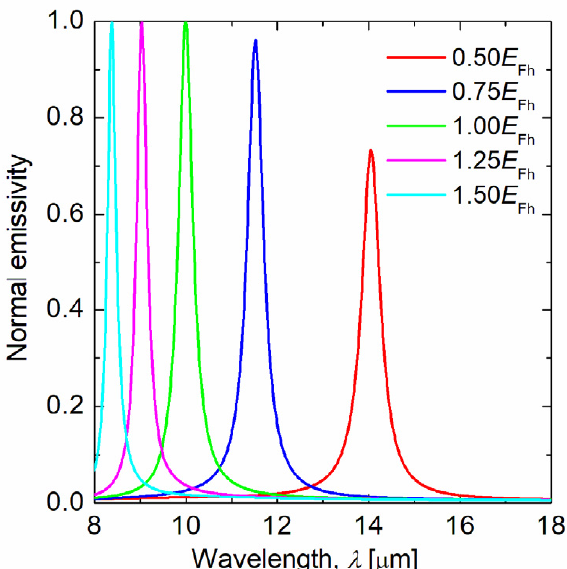
Figure 6. Normal emissivity spectrum for graphene ribbon metasurface with different Fermi energies of graphene. The target wavelength is 10 µ m, and the Fermi energy of graphene is 0.5–1.5 times of E F = 1.37 eV.